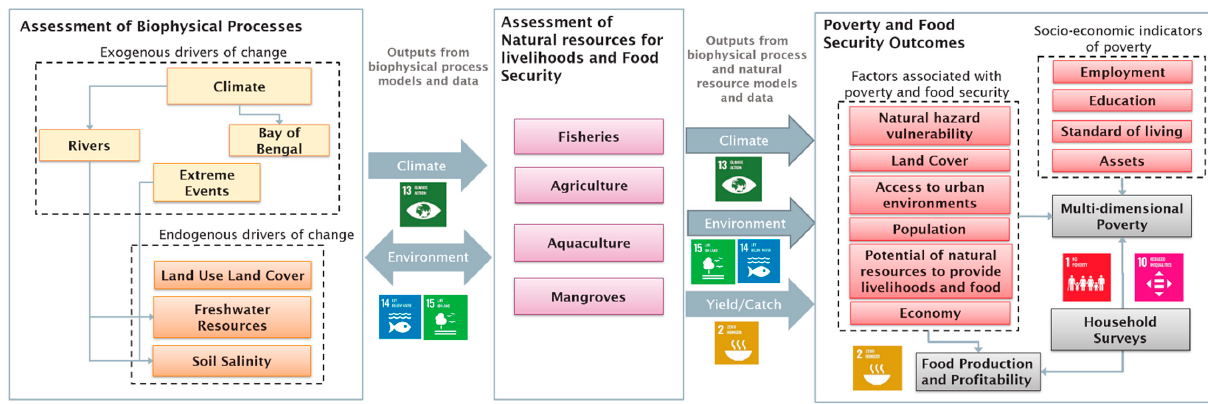
Figure 5. Proposed IAM framework for the integrated assessment of the interactions and trade-offs of selected Sustainable Development Goals within the Sundarban Biosphere Reserve. Boxes represent subcomponents where models and/or data are available for analysis. Arrows indicate information flow between subcomponents. Colors are used to group subcomponents and aid visualization. Yellow = factors acting as exogenous drivers of change, orange = factors acting as endogenous drivers of change, purple = models of natural resources linked to livelihoods, gray = socio-economic analysis, pink = factors feeding into socio-economic analysis coming from other subcomponent analysis, scenarios, and data.